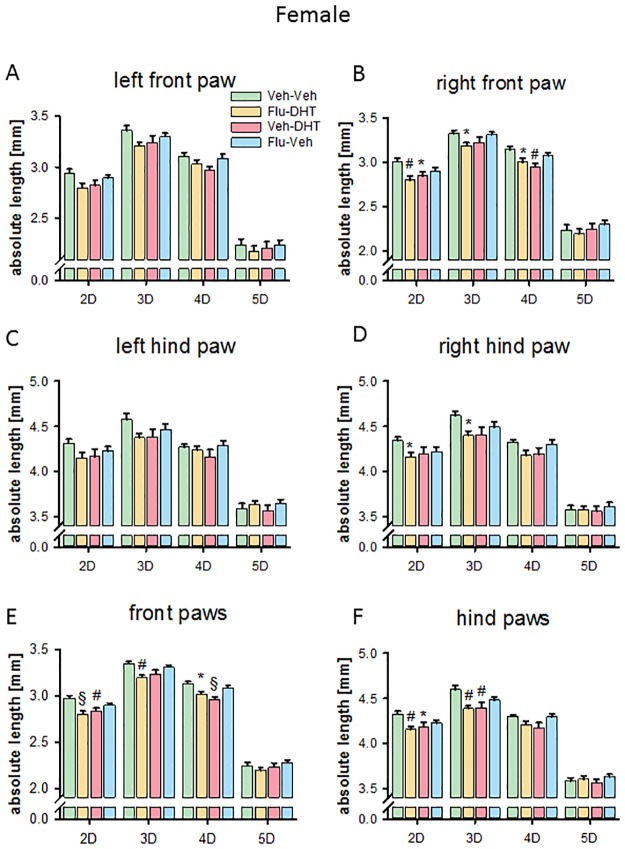
Absolute length of fingers reduced by prenatal treatment in females.Length of digits on the left (A) and the right (B) front paw. Length of digits on the left (C) and the right (D) hind paw. (E) Digit length of pooled (left + right) front paws. (F) Digit length of pooled (left + right) hind paws. Data represented as mean ± Standard error of the mean (SEM). * p<0.05, # p<0.01 and § p<0.001 compared to control. Veh—Vehicle; Flu—Flutamide; DHT—Dihydrotestosterone.